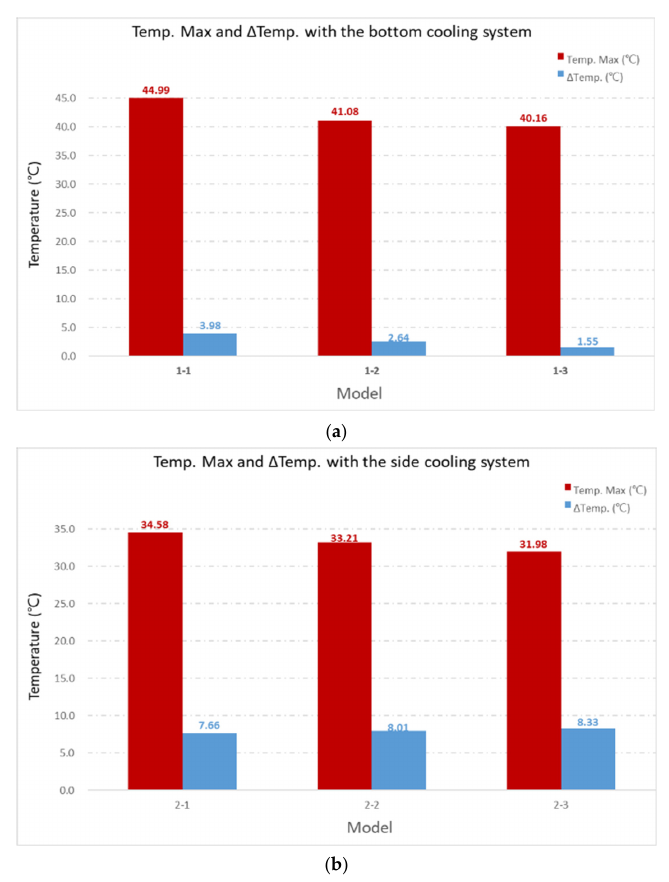
Figure 12. Max temperature and the temperature difference for the bottom ( a ) and side ( b ) cooling